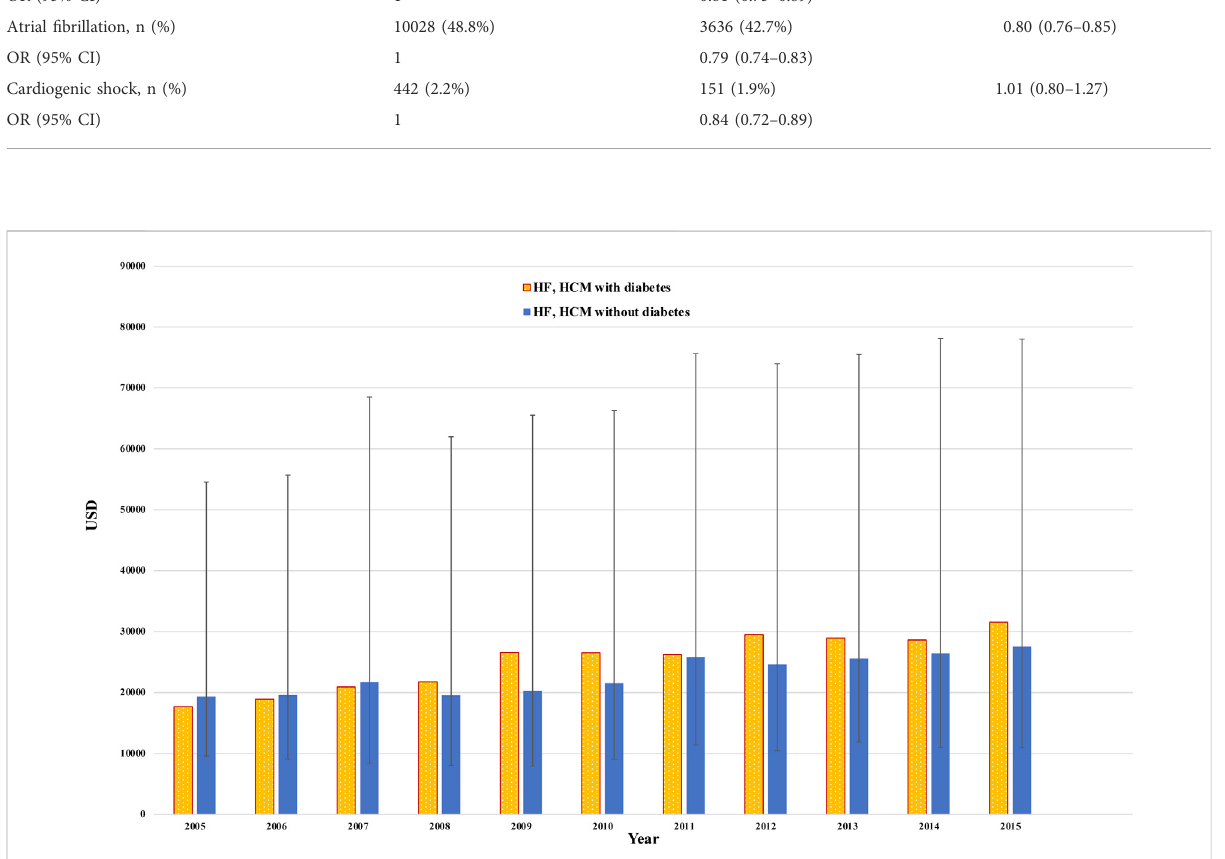
FIGURE 3 Temporal change in total charges/stay (median +/ − IQR) in heart failure patients with diabetes (yellow color) and without diabetes (blue color). The X-axis represents the amount in USD. The Y-axis represents the